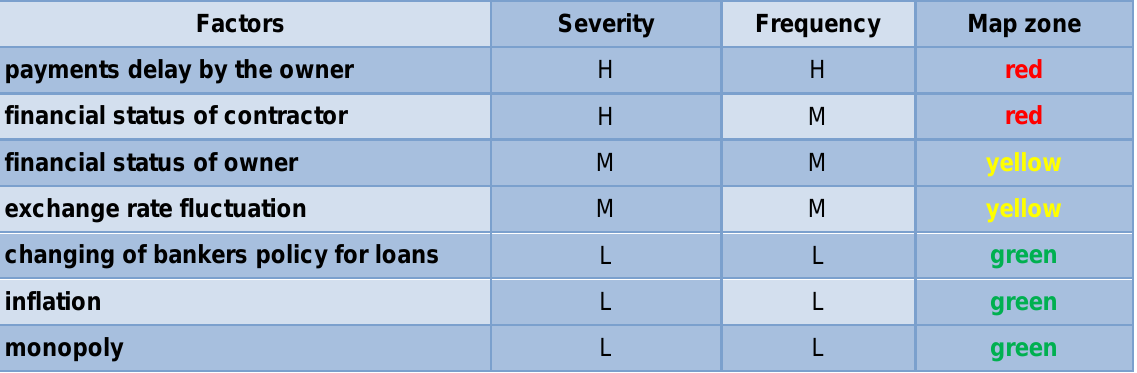
Table 5 Risk map for factors under financial